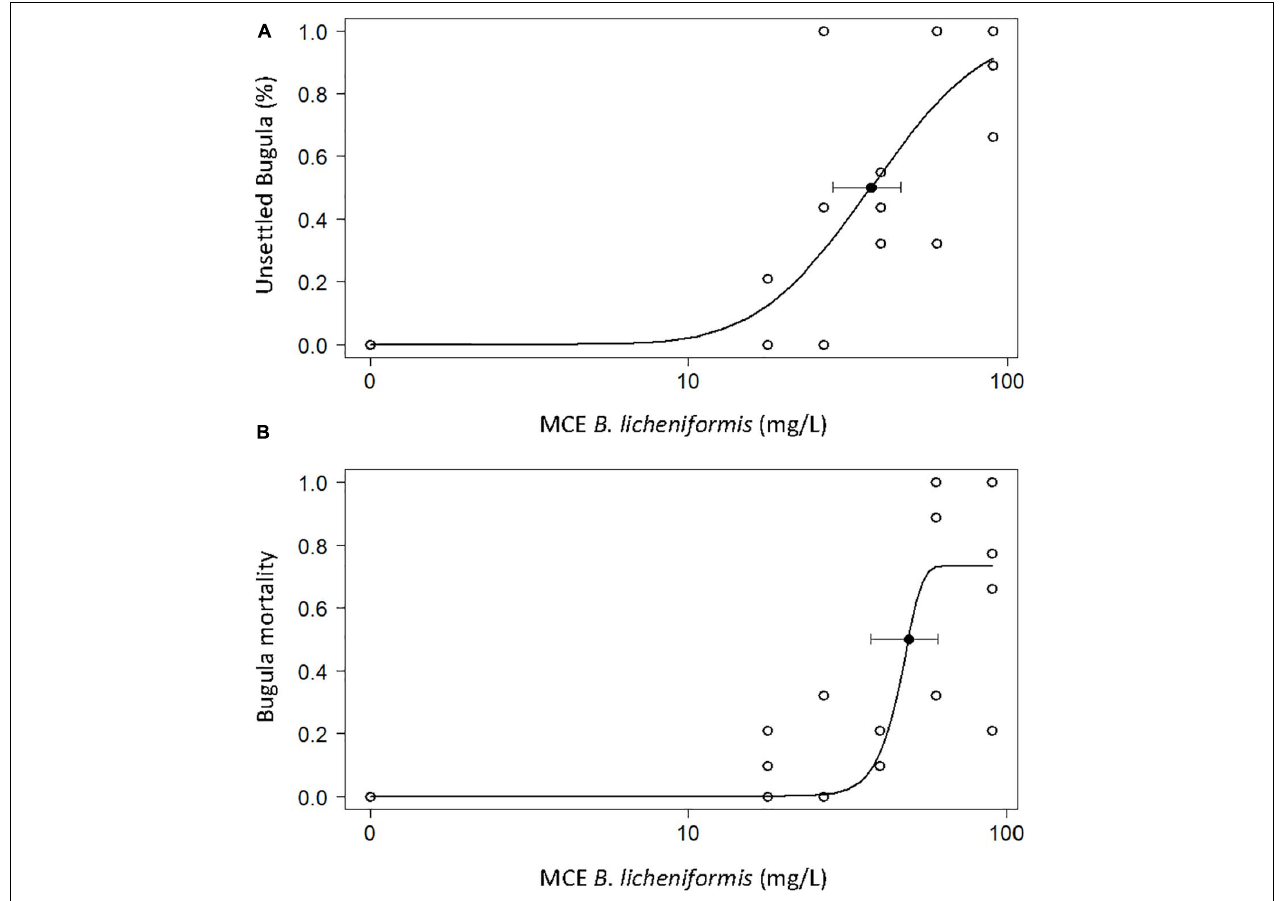
FIGURE 3 | Percentage of larvae of the bryozoan Bugula neritina larvae not settled (A) and dead (B) after exposure to the methanol cell extract (MCE) of B. licheniformis for 48 h ( n = 4 × 10). E/LC50 represented by black filled dots. EC50 = 37.39 mg/L (95% CI = 28.43–46.35 mg/L). LC50 = 49.22 mg/L (95% CI = 37.53–60.90 mg/L).